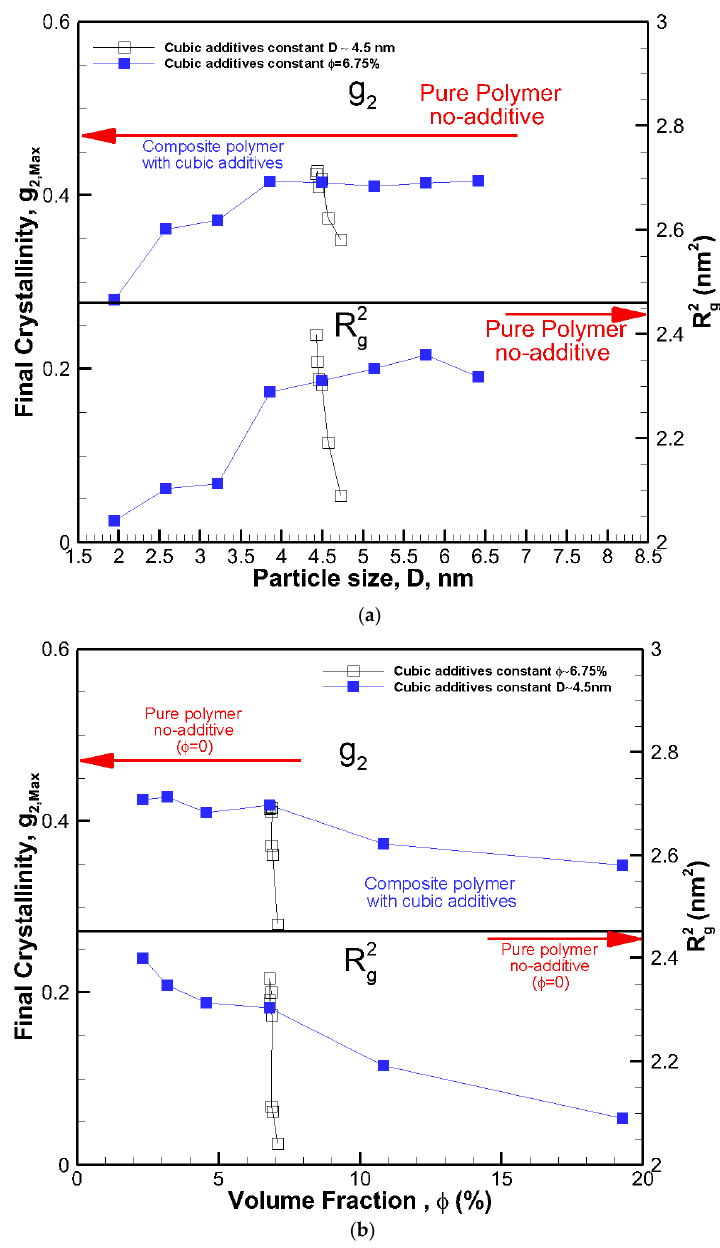
Figure 4. The final degree of crystallinity and square radius of gyration R 2g after 56.4 ns for all systems shown against cubic additive particle ( a ) size D, and ( b ) volume fraction φ . The red arrows show final crystallinity and R 2g for the pure polymer with no additive.